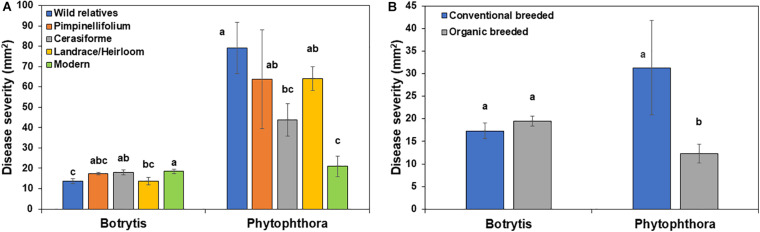
Effect of tomato (A) domestication and (B) breeding conditions on basal resistance against Botrytis cinerea and Phytophthora infestans. Columns labeled by a different letter are significantly different at P ≤ 0.05 according to Tukey-Kramer HSD test within a disease.